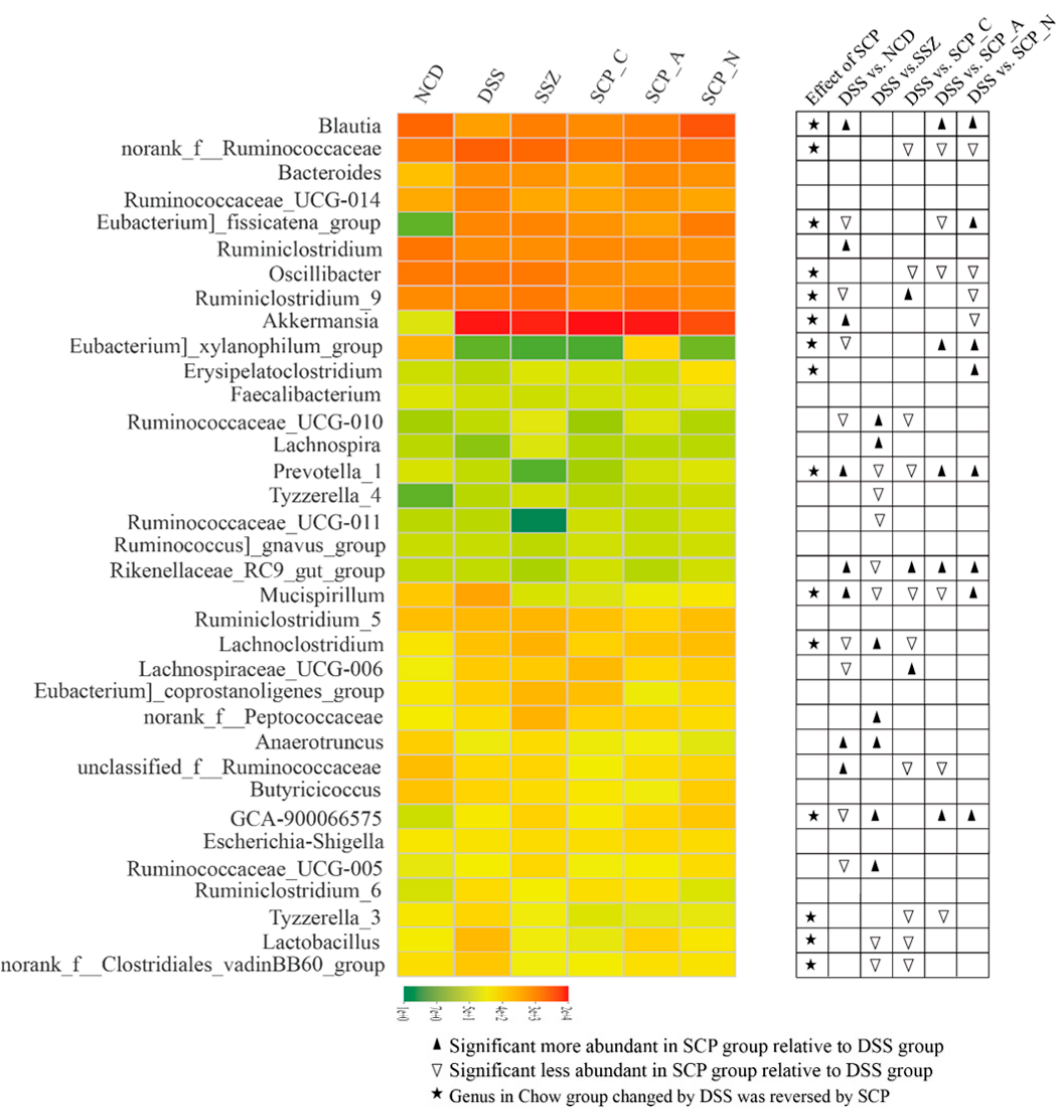
Figure 5. The relative abundance of the top 35 genera in given NCD, DSS, SCP_C, SCP_A and SCP_N was included in the heatmap. Statistical significance was determined using one-way ANOVA with Dunn’s multiple comparison